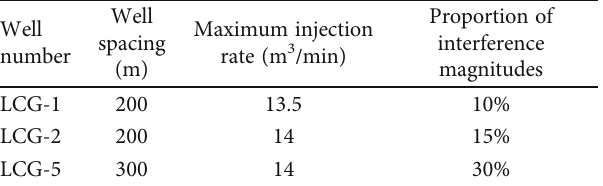
Table 3: A table for preferable well spacing and injection rate.